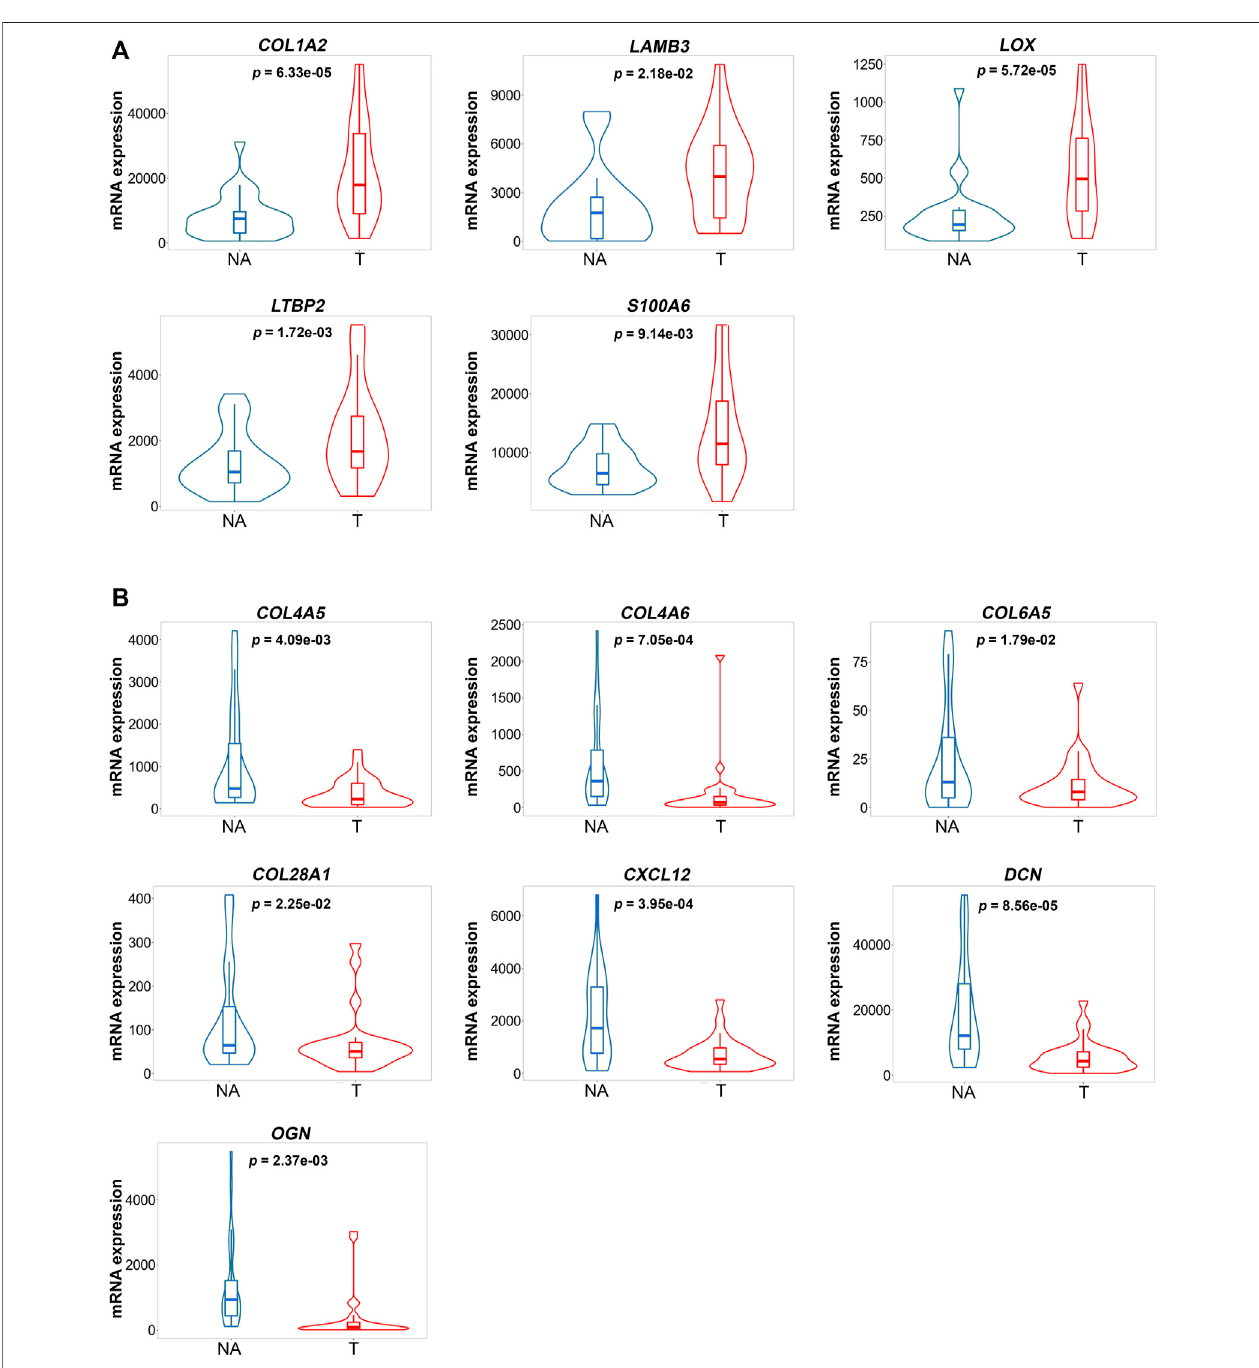
FIGURE4 | Gene expression violin plots of matrisome componentsdifferentially expressed in tumor ECM. Gastric cancer RNA-Seq expression from TCGA-STAD database comparing paired tumor (T) and normal adjacent (NA) tissue ( n = 27). ECM genes signi fi cantly upregulated (A) or downregulated (B) in tumor samples. Plots weregeneratedintheTNMplotplatform[https://tnmplot.com/analysis/;(Bartha andGy ő rffy,2021)]. Geneexpression levelswerenormalizedthroughDESeq2(median- of-ratios method). Groups were compared using the Wilcoxon test and a p value below 0.05 was considered statistically signi fi